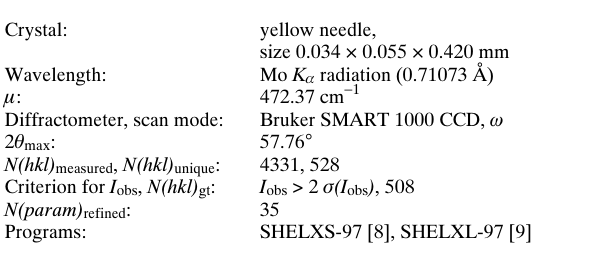
Table 1. Data collection and